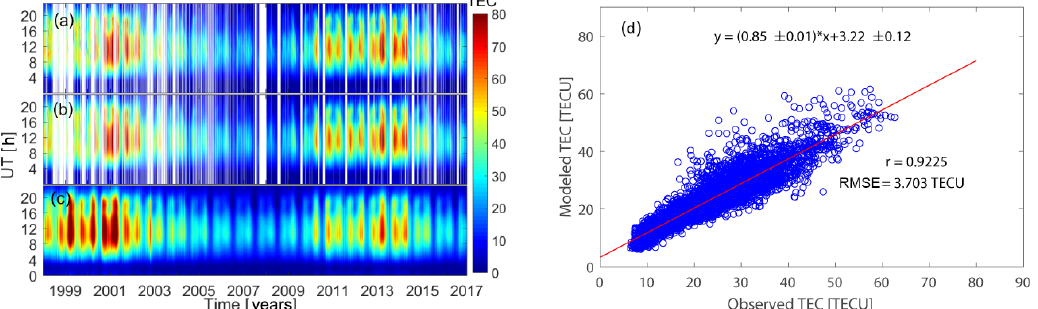
Figure 2. (a) GPS TEC, (b) reconstructed TEC and (c) modeled TEC over Malindi. (d) Correlation between EOF-modeled TEC and GPS- derived TEC over Malindi from 1999 to